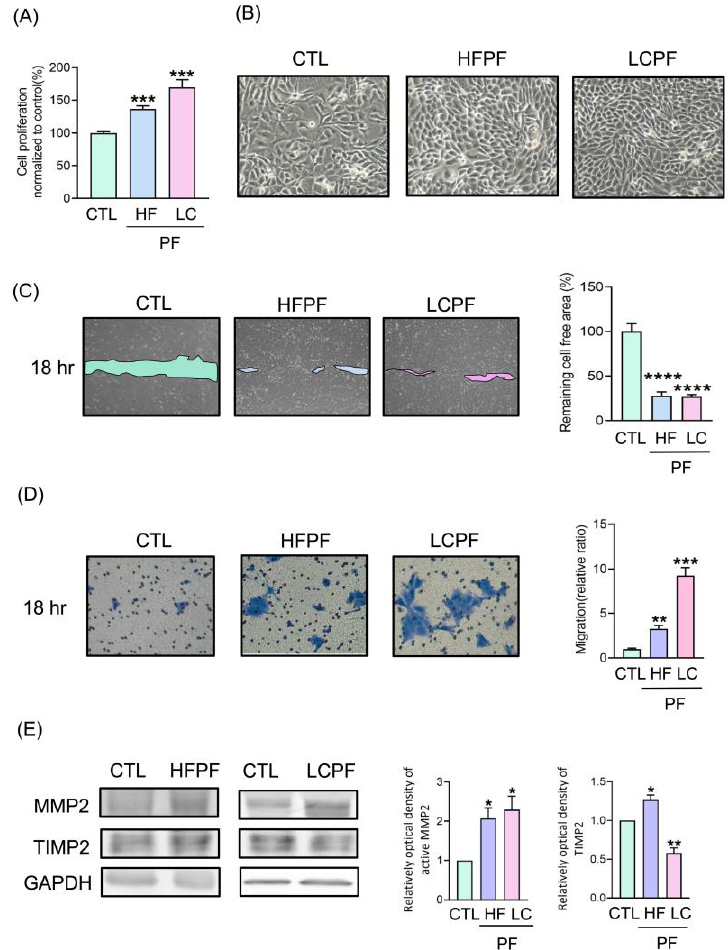
Figure 2. Effect of cell-free pleural fluid (PF) from heart failure (HF) and lung cancer (LC) patients on HaCaT viability and motility. Through sonography-guided thoracentesis, PF from heart failure (HFPF) and lung cancer (LCPF) patients were collected. ( A ) HaCaT cells were cultured with HFPF, LCPF, or control medium for 24 h. Cell viability was determined using an MTT assay. Quantification shown as bar graphs. ( B ) Representative images of HaCaT cells after being cocultured with HFPF and LCPF for 12 h. ( C ) After cells reached confluency, a scratch wound assay was applied. HaCaT cells were treated with HFPF, LCPF, or control medium for 18 h. The wound closure is demonstrated by the colored area. Bar graphs show the quantification of the cell-free area. ( D ) HaCaT was seeded in the upper Transwell chamber. After an 18 h incubation with HFPF or LCPF, the number of cells in the lower chamber was stained and counted. Bar graphs show the quantification of the migration rate. ( E ) Levels of MMP2 and TIMP2 following treatment with HFPF or LCPF for 24 h were measured by Western blotting. GAPDH was used as internal control. * p < 0.05; ** p < 0.01; *** p < 0.005; **** p < 0.0001 compared to the control group.